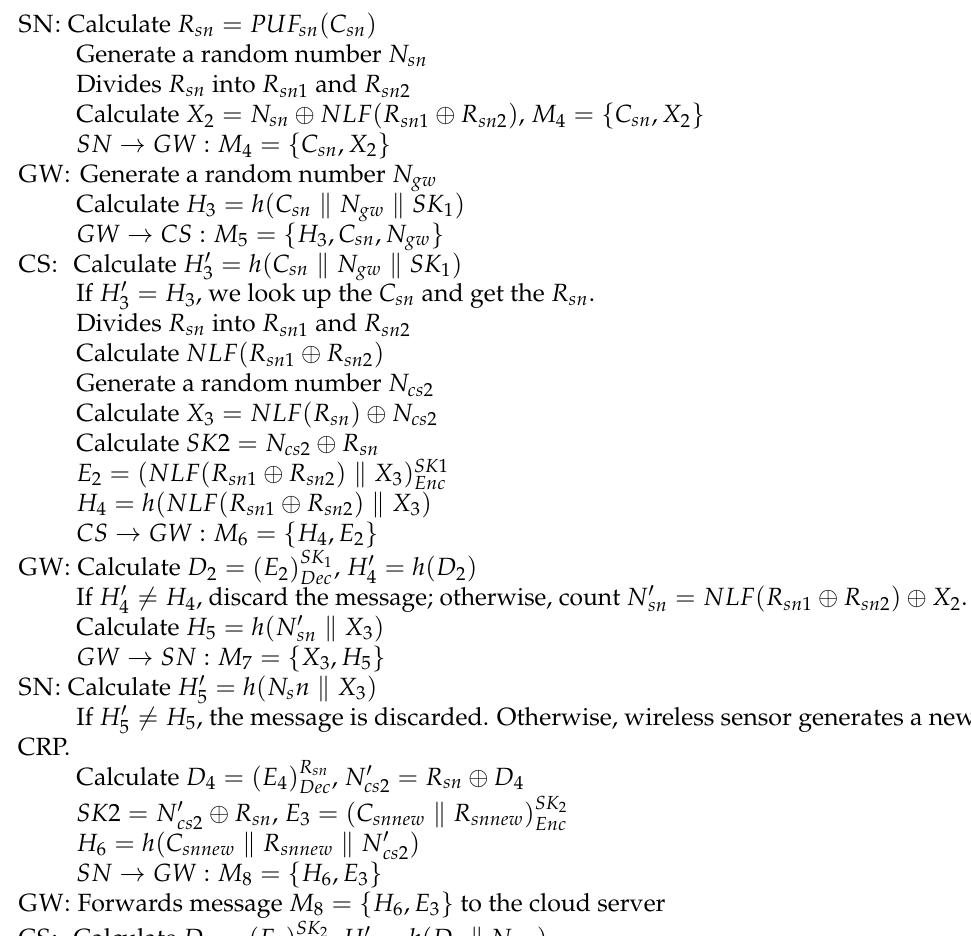
Algorithm 2 Wireless sensor authentication and key